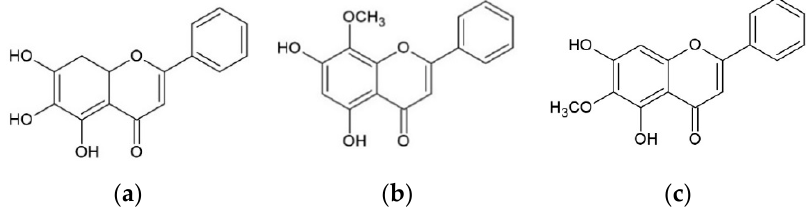
Figure 1. The chemical structures of ( a ) baicalein, ( b ) wogonin, and ( c ) oroxylin A.